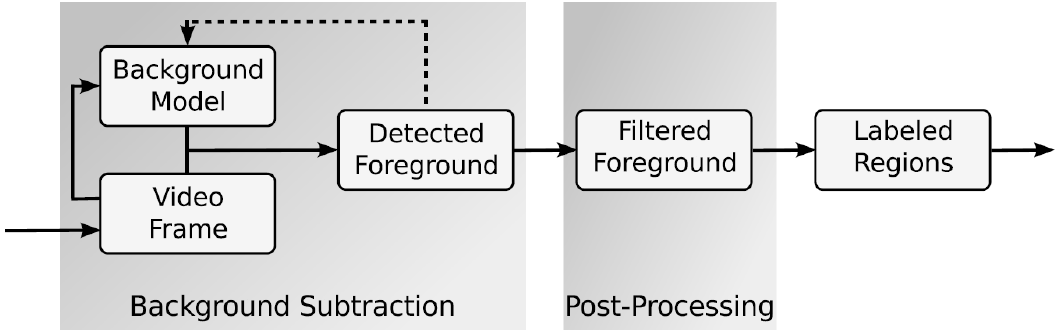
Figure 1. Typical background subtraction process with additional post-processing steps